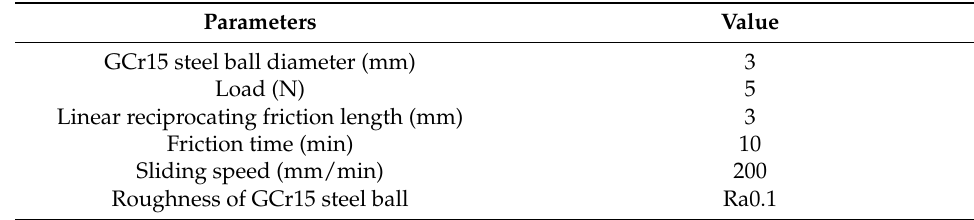
Table 4. Parameters of friction and wear.